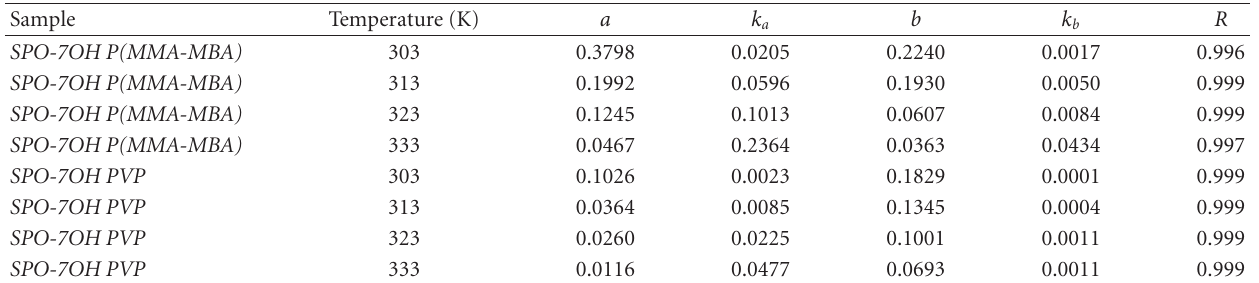
Table 2: Kinetic parameters for thermal bleaching reaction.